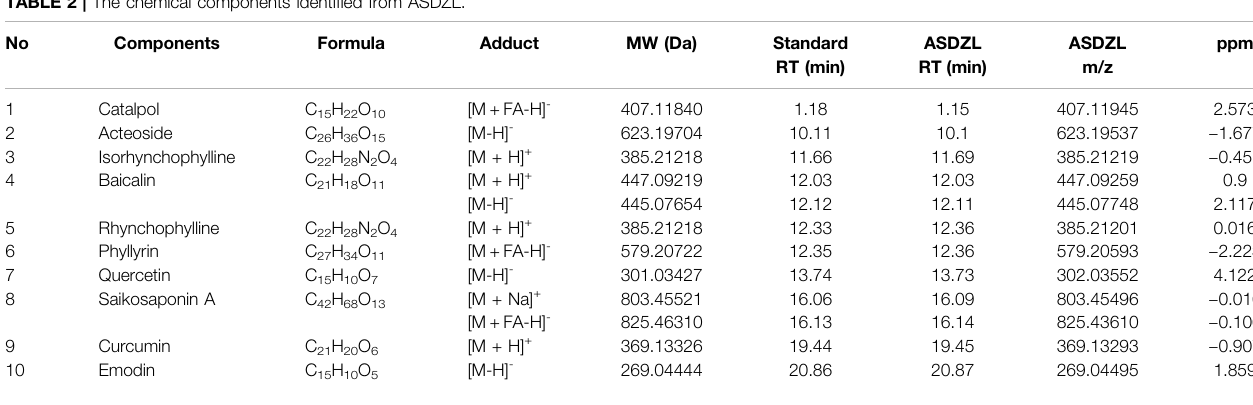
TABLE 2 | The chemical components identi fi ed from